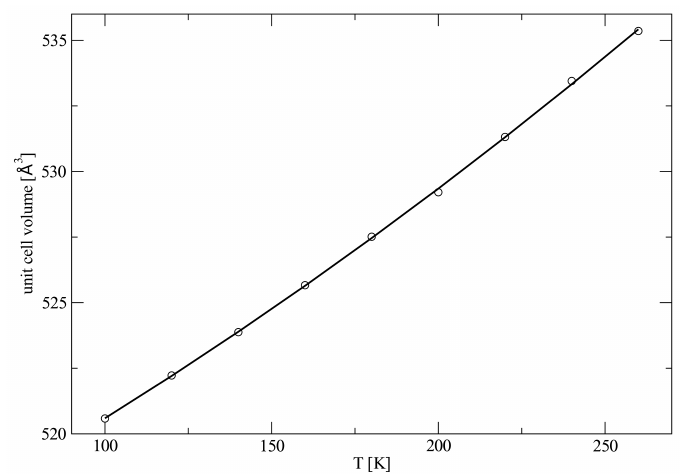
Figure 5. Temperature-dependent development of the unit cell volume. The quadratic fit results in the equation y = 513.54 + 0.062073 × x + 8.4949 × 10 − 5 × x 2 .